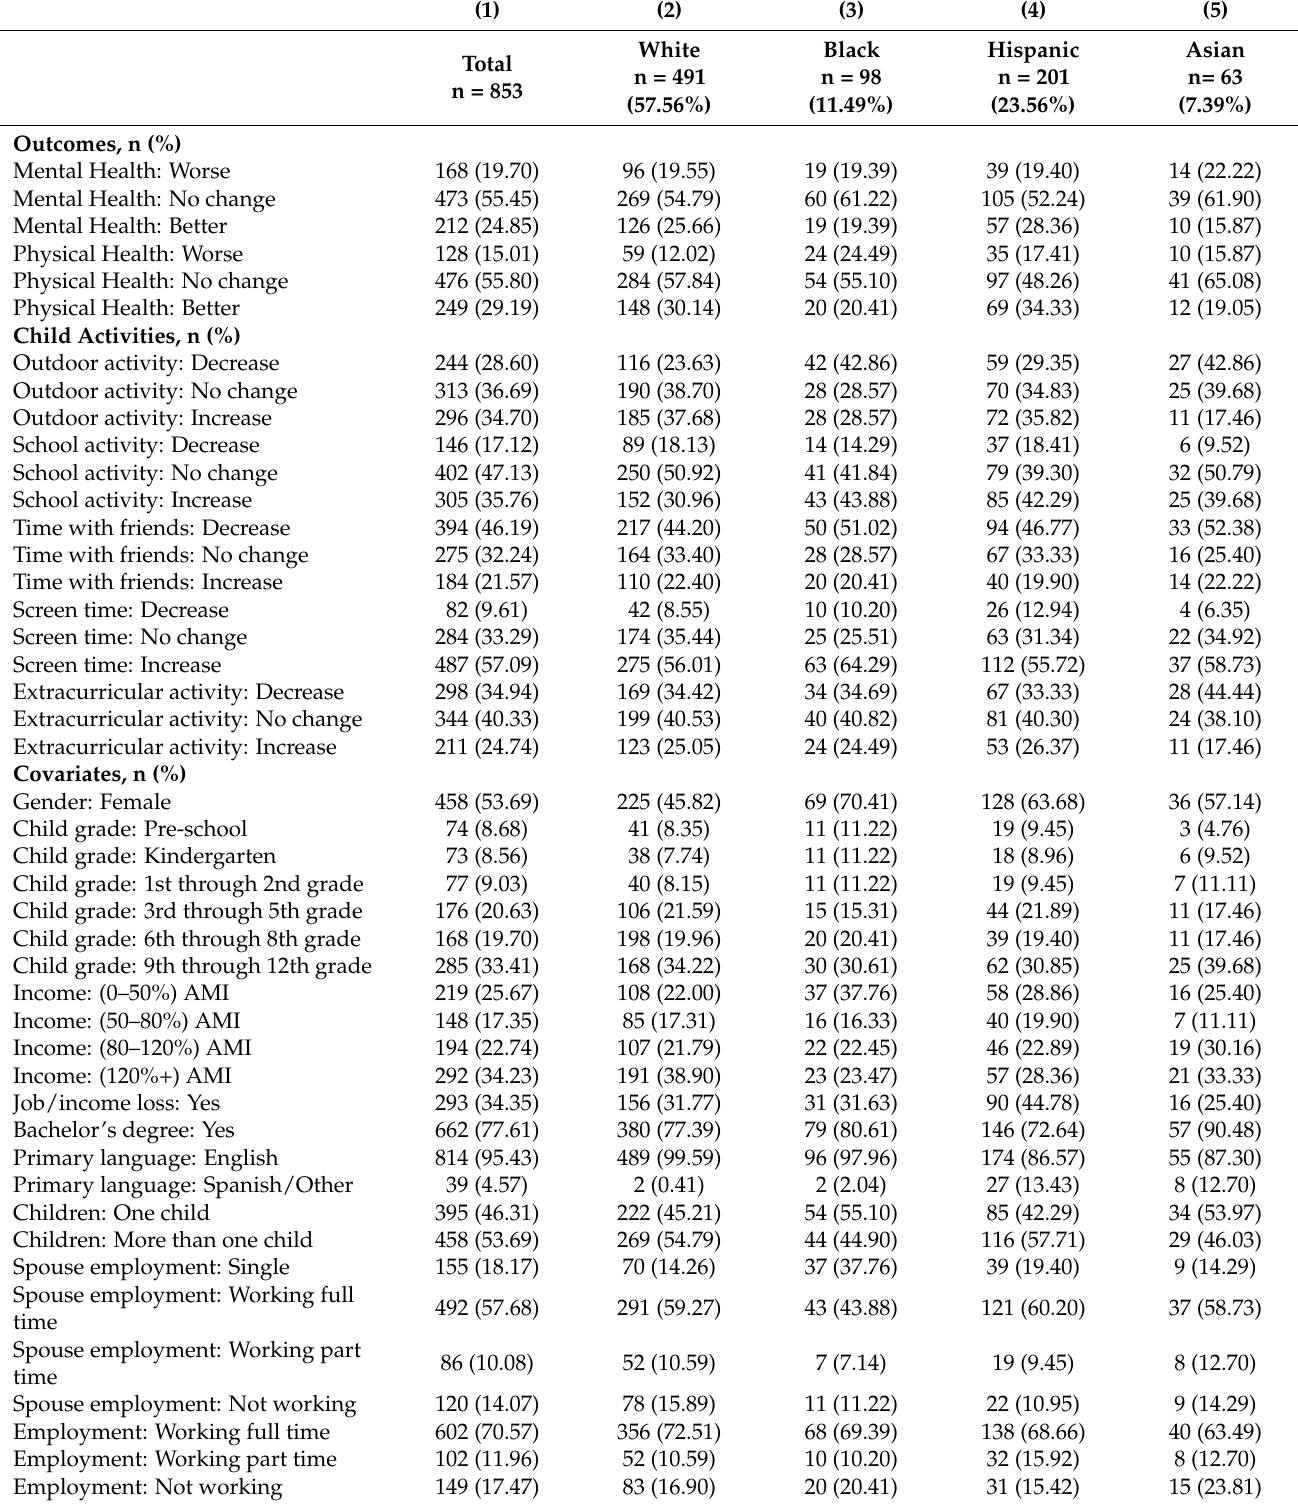
Table 1. Descriptive statistics for analytic sample (n = 853) by